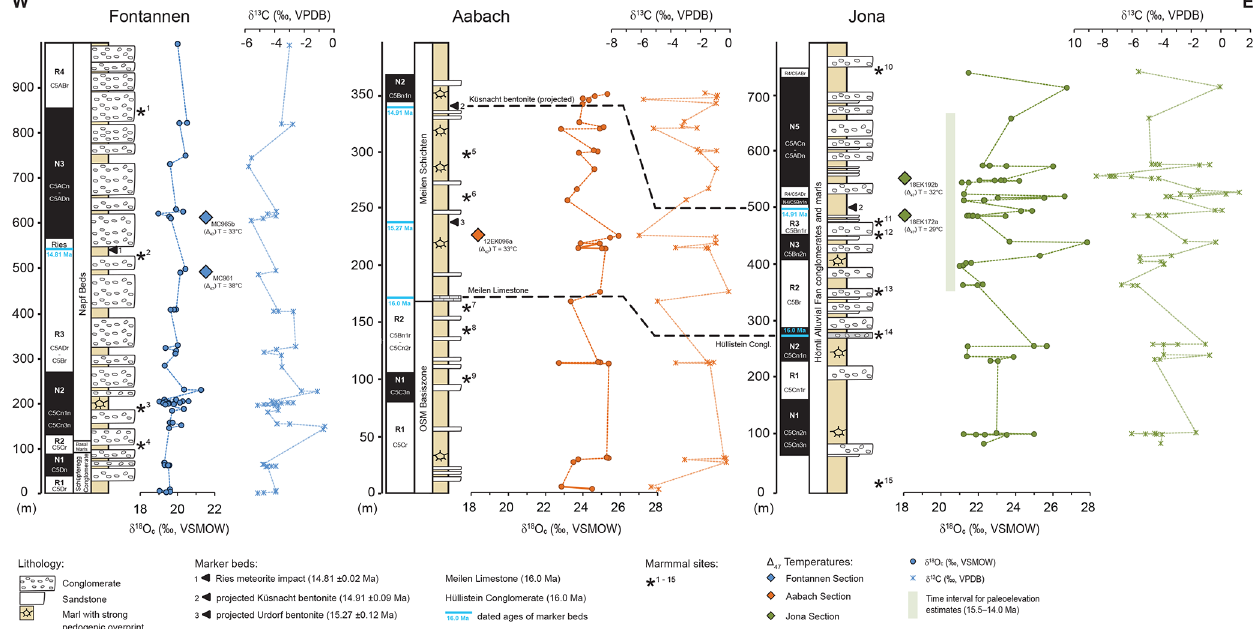
Figure 2. Magnetostratigraphy and pedogenic carbonate δ 18 O and δ 13 C values for Swiss Molasse Basin sections. In total, 141 individual carbonate nodules were analyzed for Fontannen (Campani et al., 2012) and Jona, as well as 101 for Aabach. Only the mean value for each carbonate bearing horizon is shown here (Fontannen n = 50; Jona n = 56; Aabach n = 34). δ 18 O c and δ 13 C values are plotted next to their stratigraphic position. Assignment of polarity chrons to the ATNTS2012 is according to Kempf et al. (1997), Kempf and Matter (1999), and Schlunegger et al. (1996). Also shown is the stratigraphic position of important marker beds (Küsnacht bentonite, Meilen Limestone and its equivalent for proximal regions, the Hüllistein Conglomerate) with dated ages. Stars show locations of mammal sites ( (cid:63) 1 projected Oeschgraben (MN 6), (cid:63) 2 Chatzloch (Frohberg, MN 5), (cid:63) 3 Vermes 1 (MN 5), (cid:63) 4 Tägermaustrasse (MN 4), (cid:63) 5 projected Hirschengrabentunnel (uppermost MN 5), (cid:63) 6 Tobelholz (middle–upper MN 5), (cid:63) 7 Aabach 2 (middle MN 5), (cid:63) 8 Aabach 3 (middle MN 5), (cid:63) 9 Käpfnach-Rotwegstollen (middle MN5), (cid:63) 10 Bachtel-Ornberg (uppermost MN 6), (cid:63) 11 Frohberg (MN 5), (cid:63) 12 Tobel Hombrechtikon (upper MN 5), (cid:63) 13 Güntisberg (middle MN 5), (cid:63) 14 Martinsbrünneli (middle MN 5), (cid:63) 15 Hubertingen – MN 4b). Mammal sites are after Kälin (1997) and Bolliger (1992). Stratigraphic names are after Büchi (1959), Kempf et al. (1997), and Matter (1964). Colored diamonds represent obtained ( (cid:49) 47 ) temperatures for each section. Fontannen ( (cid:49) 47 ) temperatures are from Methner et al. (2020). Each stratigraphic section covers an age range of ca. 17.5 to 14Ma (see the